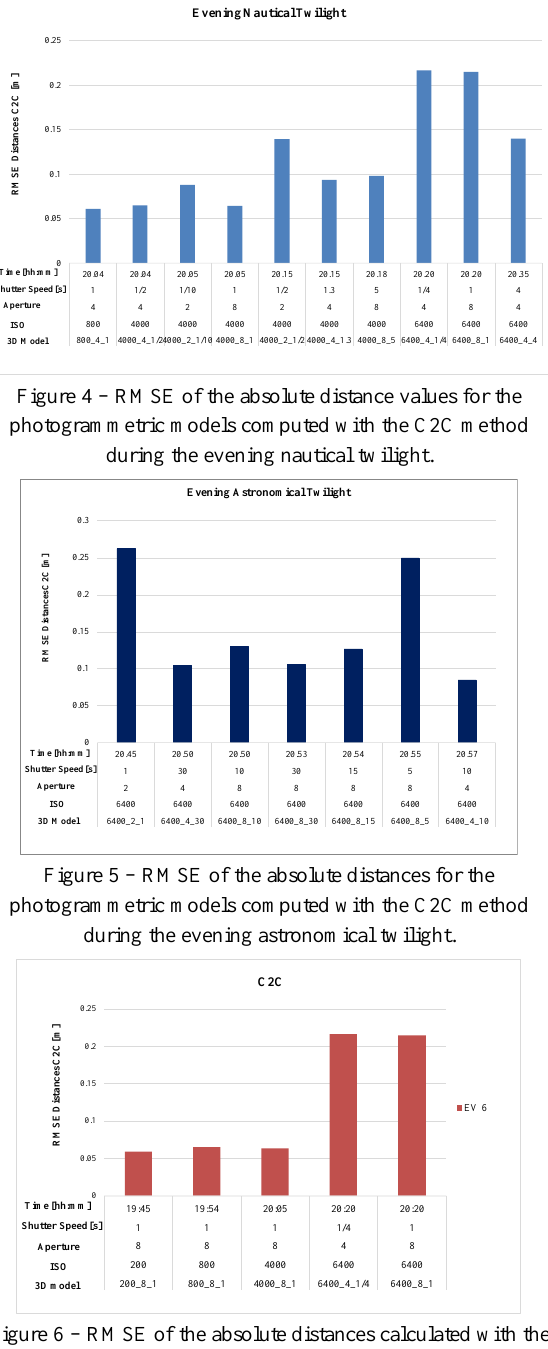
Figure 6 – RMSE of the absolute distances calculated with the C2C method for 3D models with the Exposure Value (EV) of